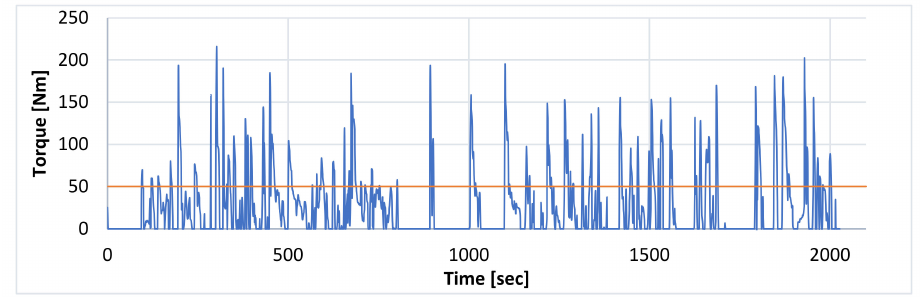
Figure 5. Changes in the total driving torque with the average value marked for “eco” driving.